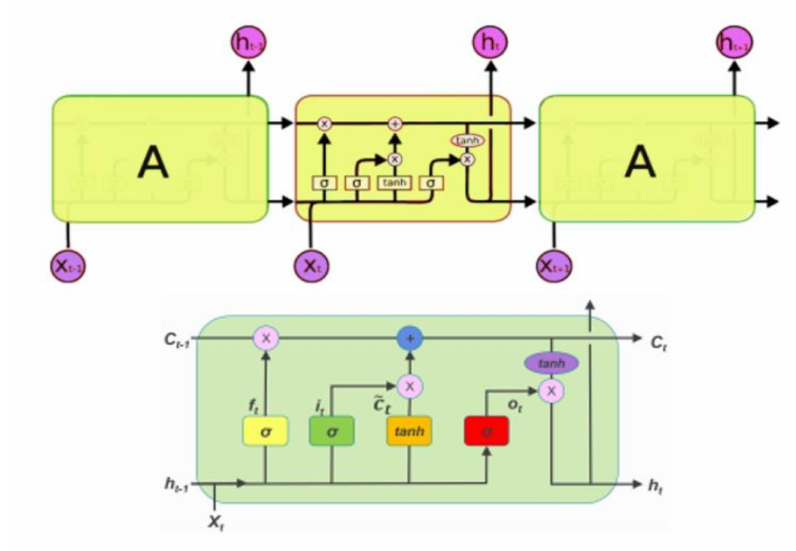
Figure 5. Long short-term memory neural network.